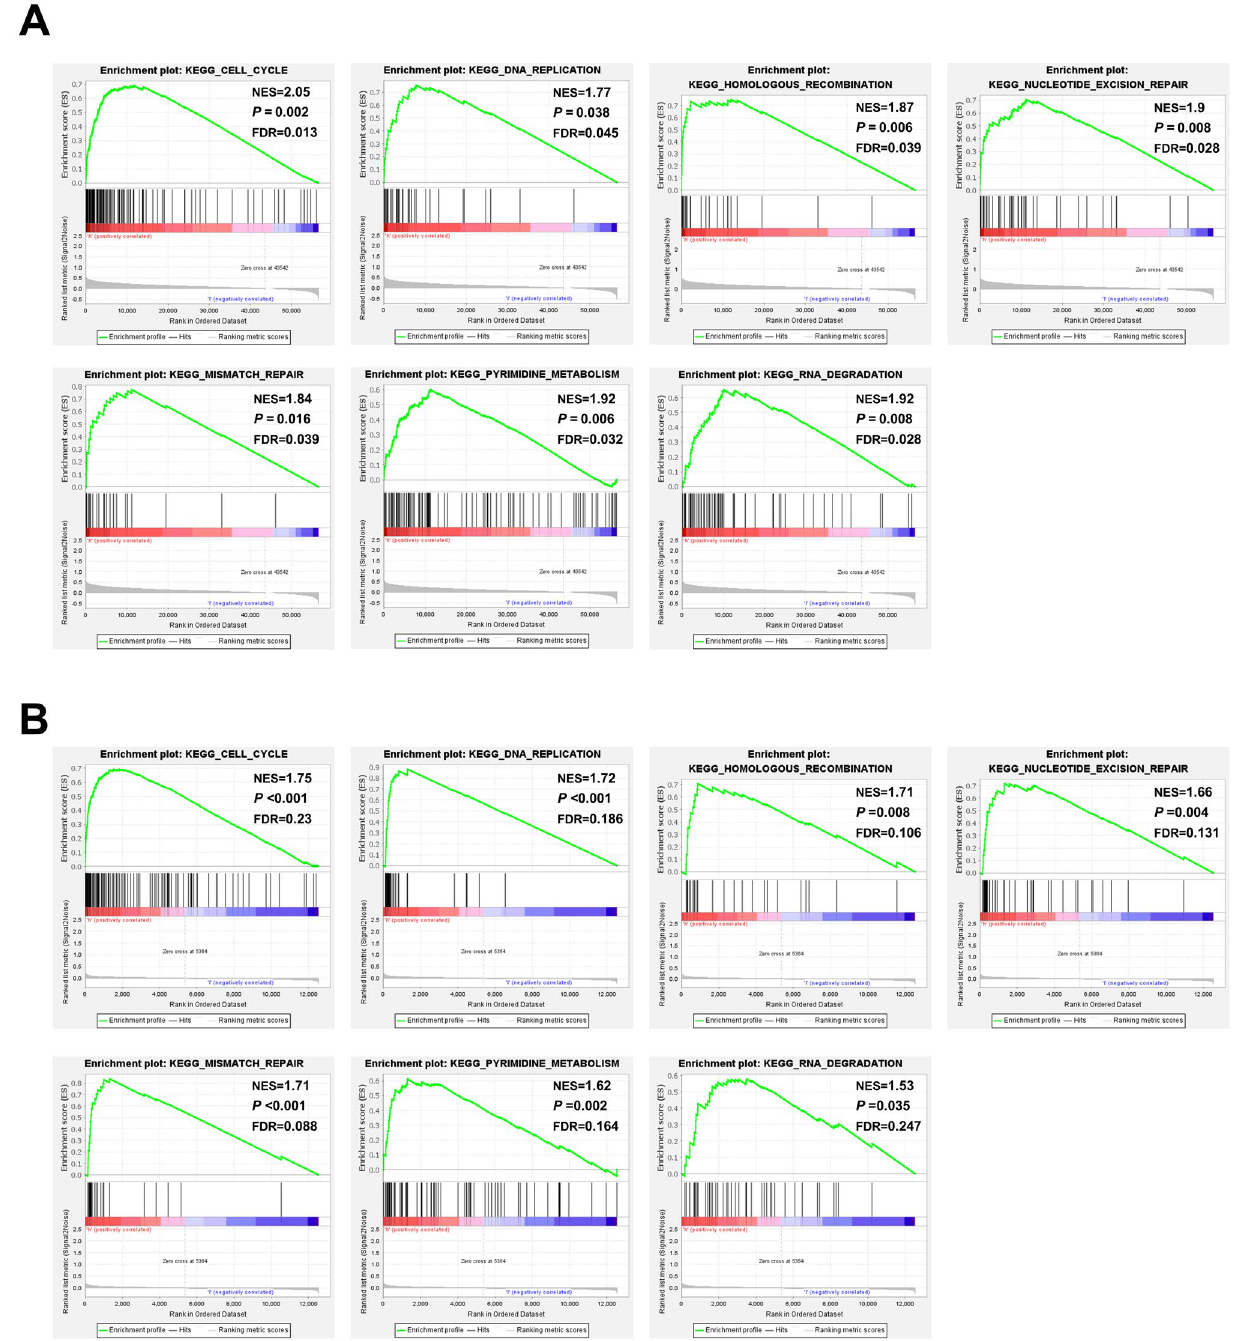
Figure 5. Identification of hypoxia-related signaling pathways with GSEA. ( A ) GSEA (http:// www. gsea- msigdb. org/ gsea/ index. jsp) results of the gene KEGG enrichment in the AML patients from TARGET; ( B ) further validation by the GEO